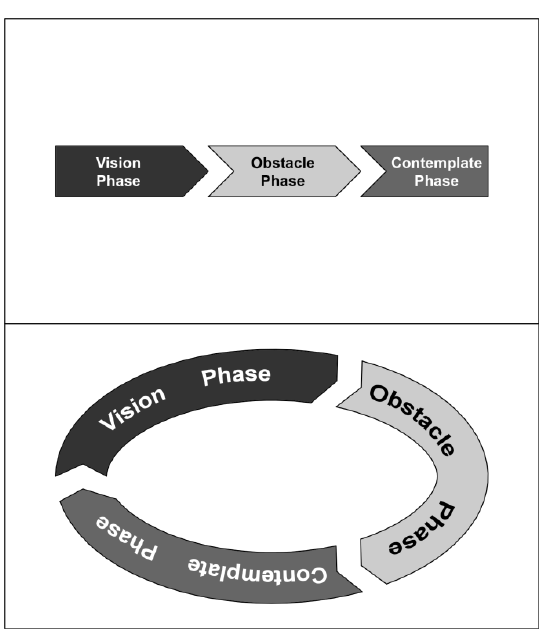
Figure 4. Linier and Cycle path as Urban sprawl phases (Illustrations by